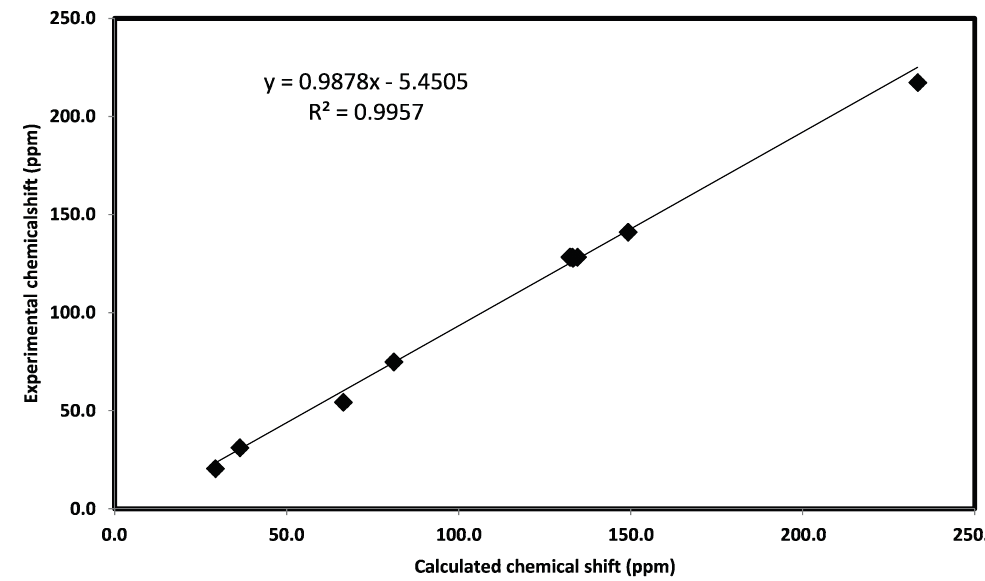
Figure 9. The correlation graph between calculated and experimental 1 H-NMR and 13 C-NMR chemical shifts of the studied